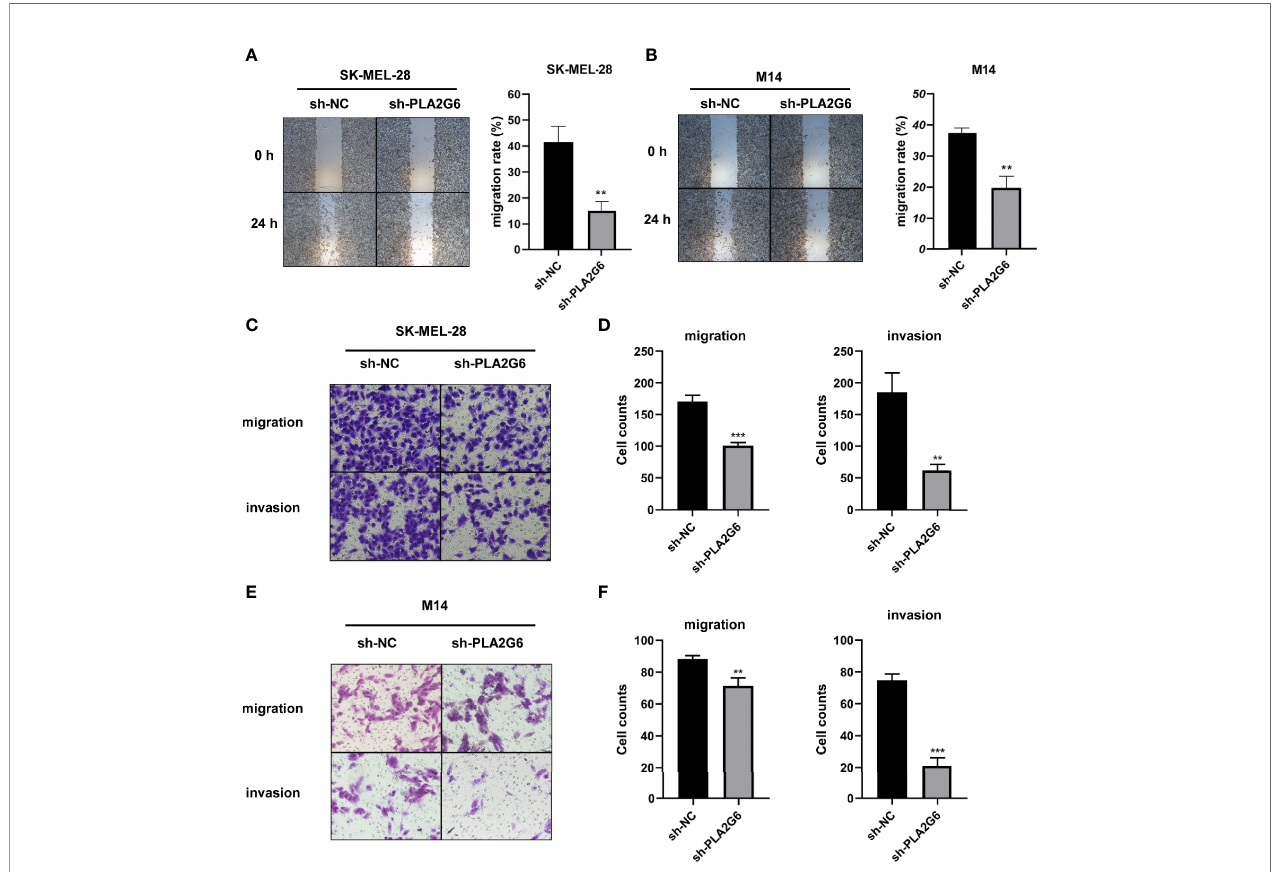
FIGURE 4 | PLA2G6 knockdown inhibits migration and invasion of CMM cells. (A) Representative microscopic images and quanti fi cation of scratch wound assays in SK-MEL-28 and (B) M14 cells. (C) The representative images (magni fi cation × 200) and number of migrated cells and (D) invaded cells of SK-MEL-28. (E) The representative images (magni fi cation ×200) and number of migrated cells and (F) invaded cells of M14. ** P < 0.01, *** P <